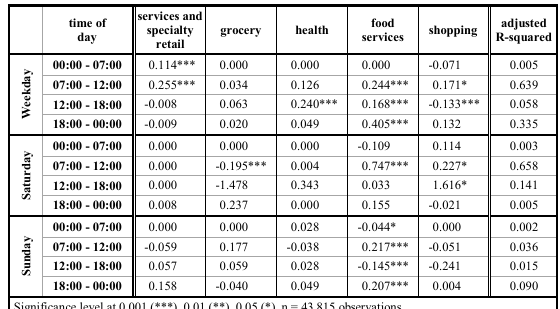
Table 3: Standardized regression results of slot wise multiple linear regression analysis of the car park ‘Kronberger